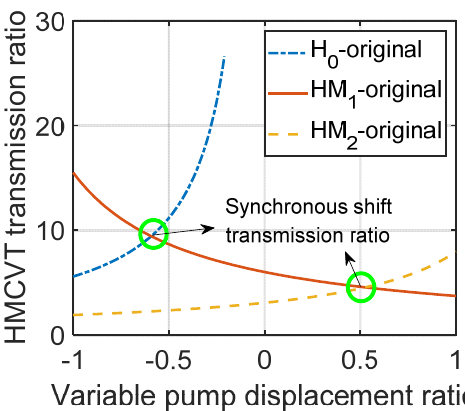
Figure 4. The original transmission characteristics of HMCVT researched.